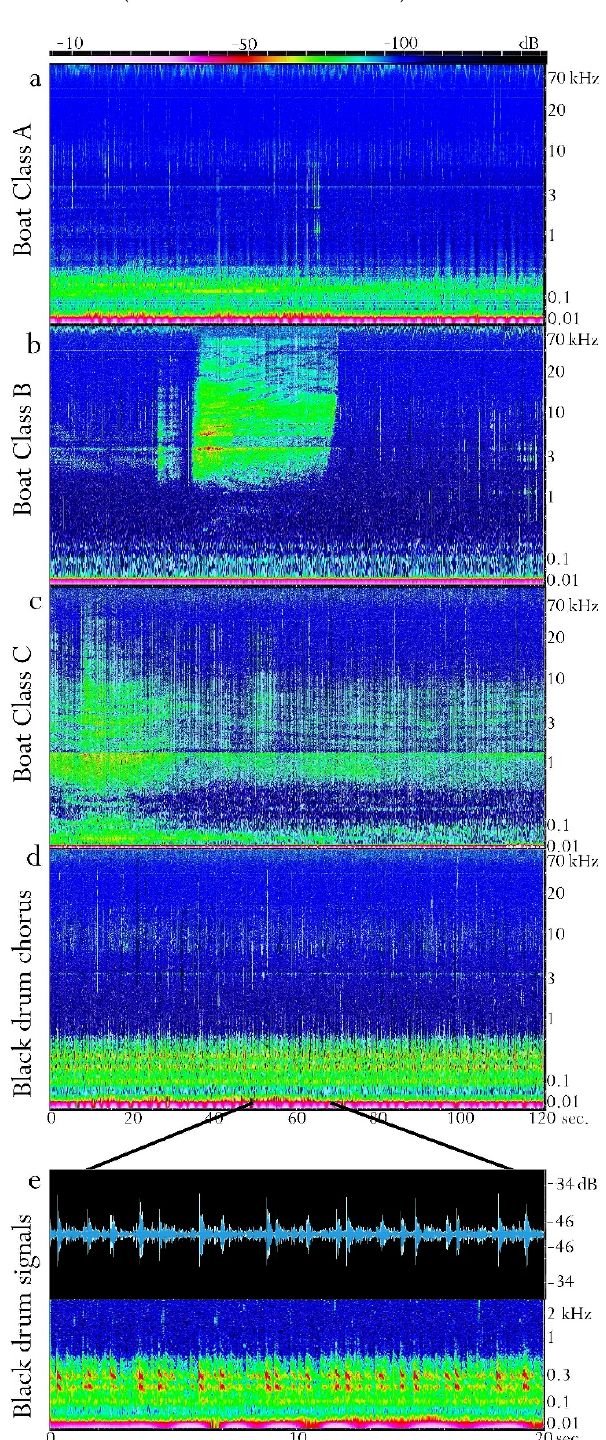
Figure 2. Spectrograms (sampling frequency = 192 kHz, FFT size = 16384, Hamming windows) of 120 s of recordings with: ( a ) boat noise of class A; ( b ) boat noise of class B; ( c ) boat noise of class C; ( d ) black drum chorus. In ( e ) a zoomed portion (20 s) of spectrogram and waveform of black drum signals. The frequency is on a logarithmic scale. The count of single drum calls was carried out by combining automatic and manual analysis. First, all acoustic files were downsampled from 192 Hz to 6 kHz. Using the merge function of Avisoft SASlab Pro software (Avisoft-SASLab Pro-Avisoft Bioacoustics), one